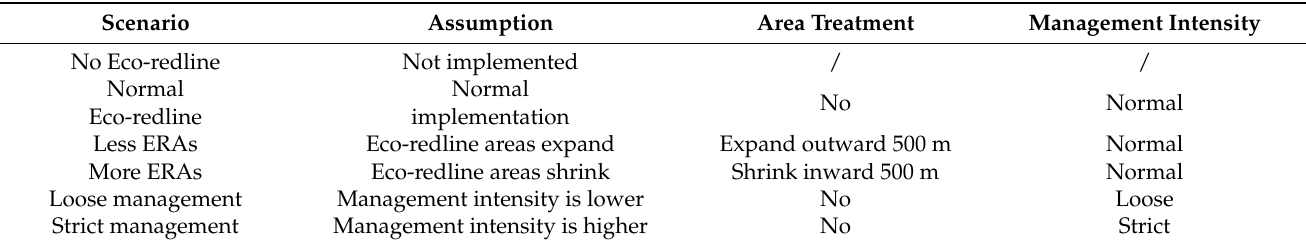
Table 8. Future scenarios for Eco-redline policy.